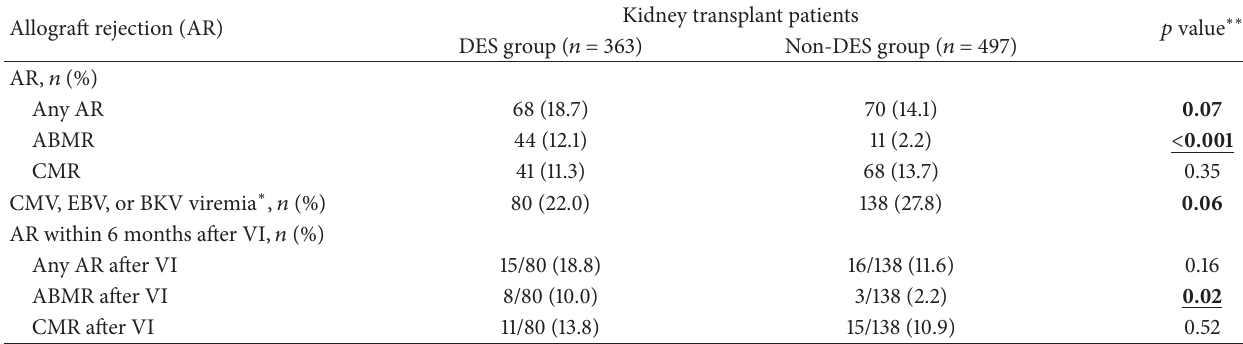
Table 6: Viral infection and allograft rejection (AR) in DES and non-DES patients. Allograft rejection